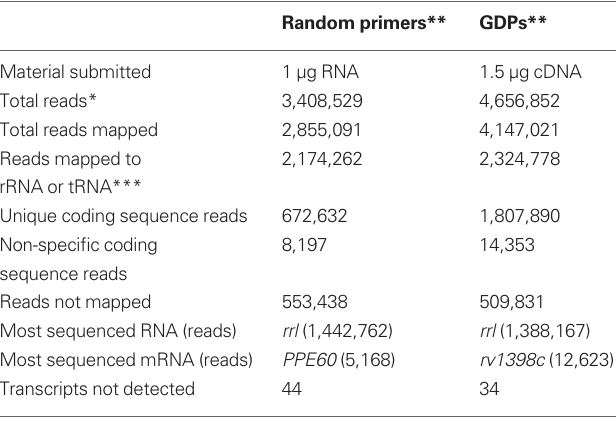
Table 1 | Results from RNA-Seq of M. tuberculosis grown in vitro using random primers vs. genome-directed primers